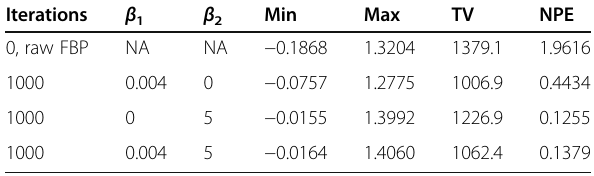
Table 4 Values of maximum, minimum, metal-free region TV, and NPE in reconstructions of bag #4